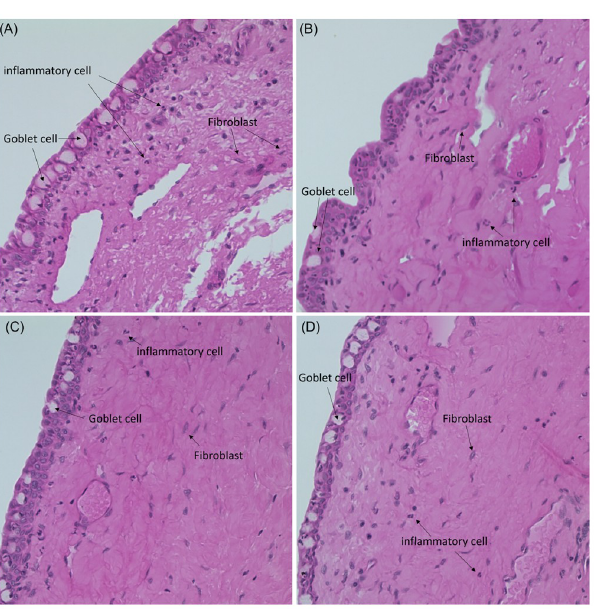
Fig 8. Representative images following H&E staining. (A) NS = 0.9% normal saline, (B) MMC = 0.5% mitomycin, (C) SR = sirolimus, and (D) TC = tacrolimus (Light microscopy, 400 × ).